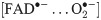
Characterization of RF effects in the [FAD•−…O2•−] radical pair.A-C: The singlet product probability change was calculated for a model including 8 isotropic hyperfine interactions on FAD•− and none on O2•−, with (A and C) or without (B) a static external magnetic field of B0 = 50 μT along the z-axis. All calculations assumed kS = kT = 1 μs−1. Once the static external magnetic field is present, significant singlet probability changes are only seen for RF frequencies below 7 MHz as illustrated in C. D: The resonance frequencies of the system calculated from the eigenvalues of the spin Hamiltonian. E: The nuclei N5, N10, H6, 3 × H8 and 2 × Hβ on FAD were used.